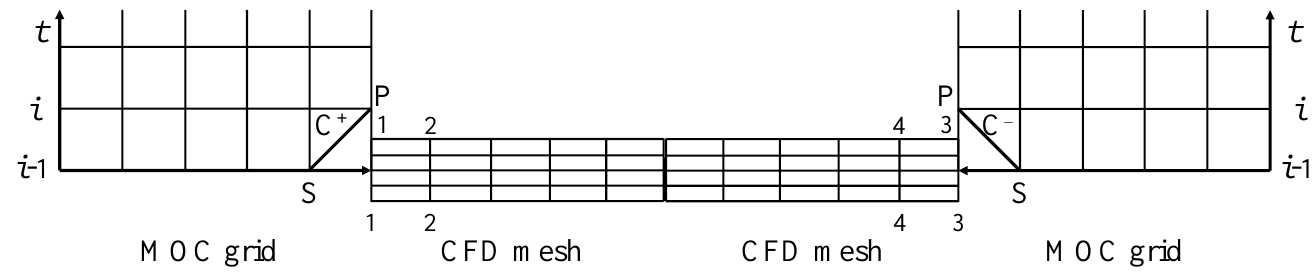
Figure 1. Schematic diagram of the 1D – 3D coupling.